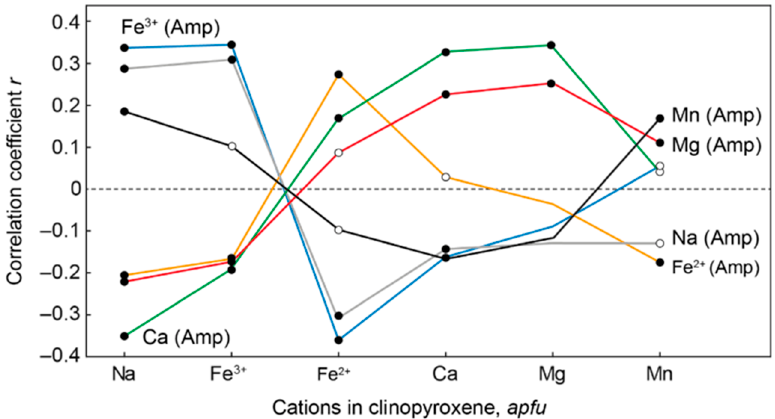
Figure 15. Correlation coefficients between the cations of coexisting amphiboles and clinopyroxenes. Black and empty dots indicate significant ( p ≤ 0.05) and insignificant correlation coefficients, respectively.